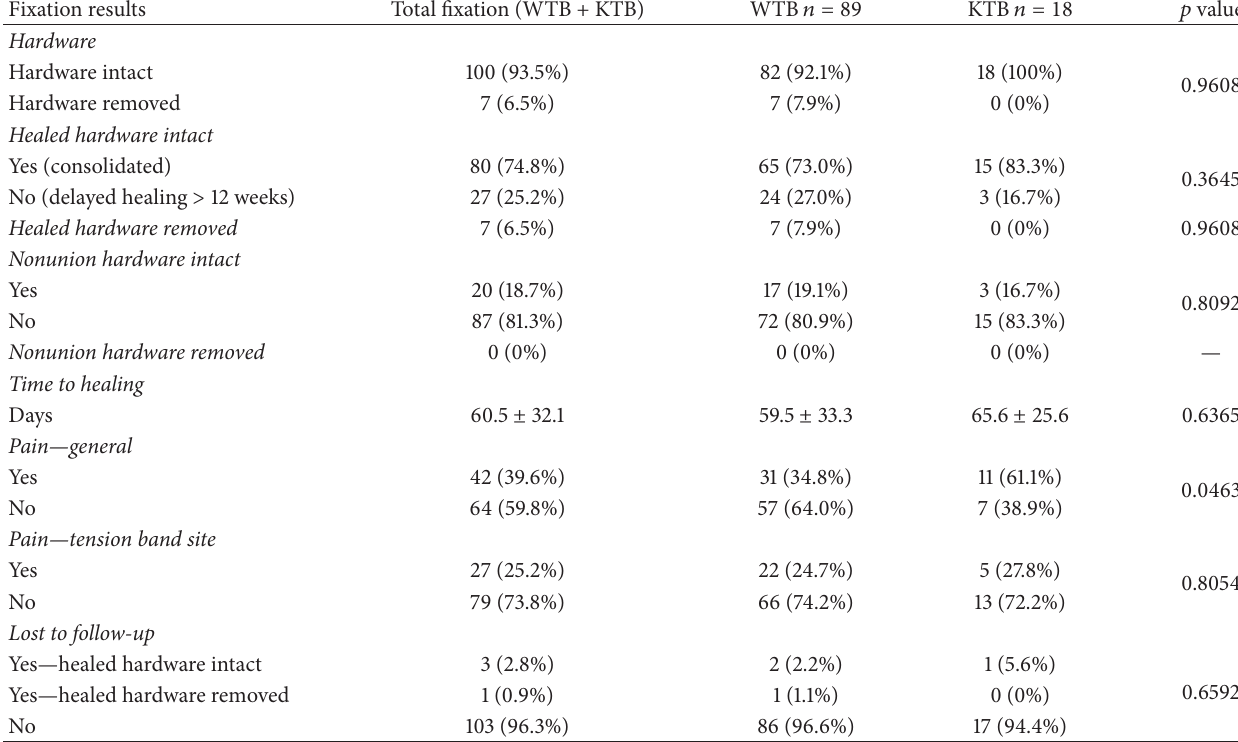
Table5:Fixationfindingswith 𝑝 valueasdeterminedusingachi-squareofindependencetestforbivariateanalysisaswellaslogisticregression